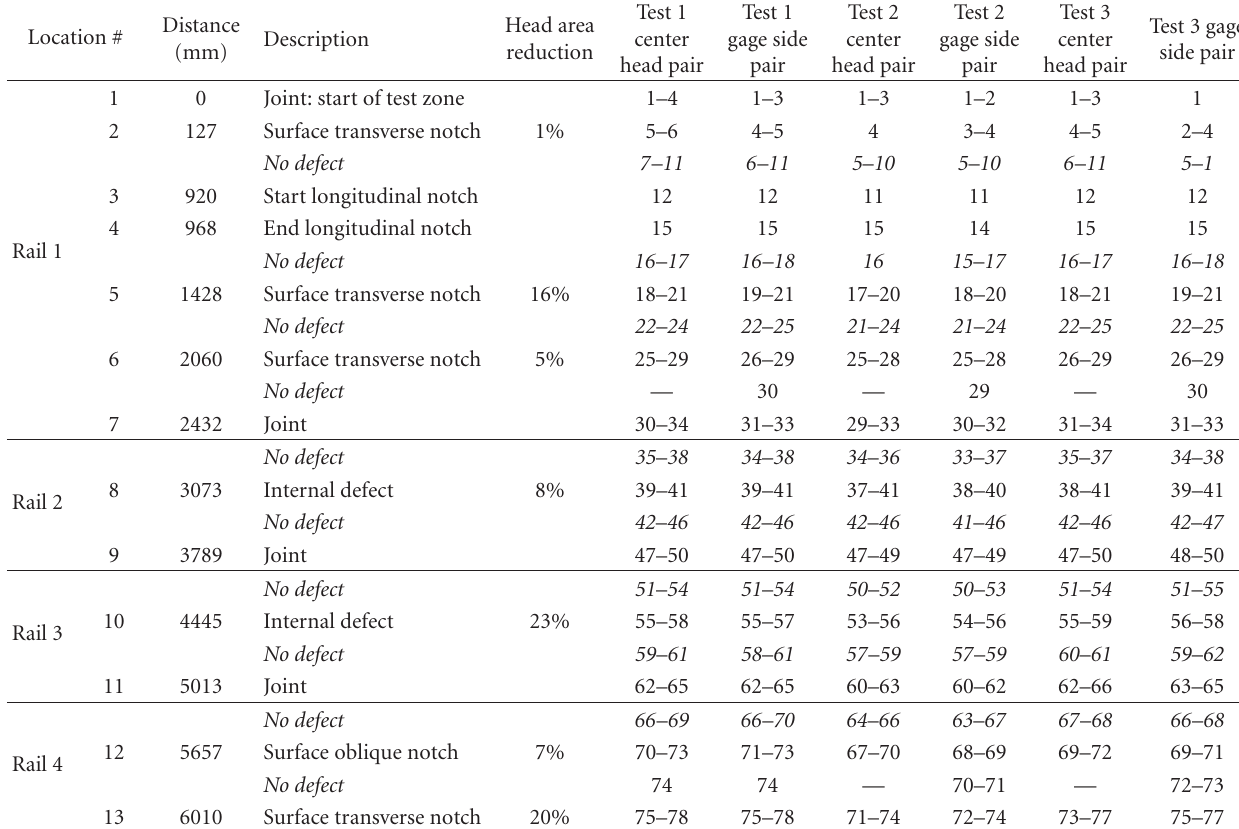
Table 1: Laboratory test site layout.